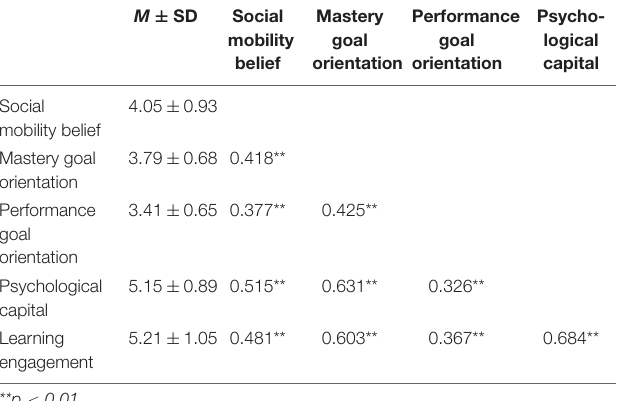
TABLE 2 | Descriptive statistics and correlation analysis results of variables.